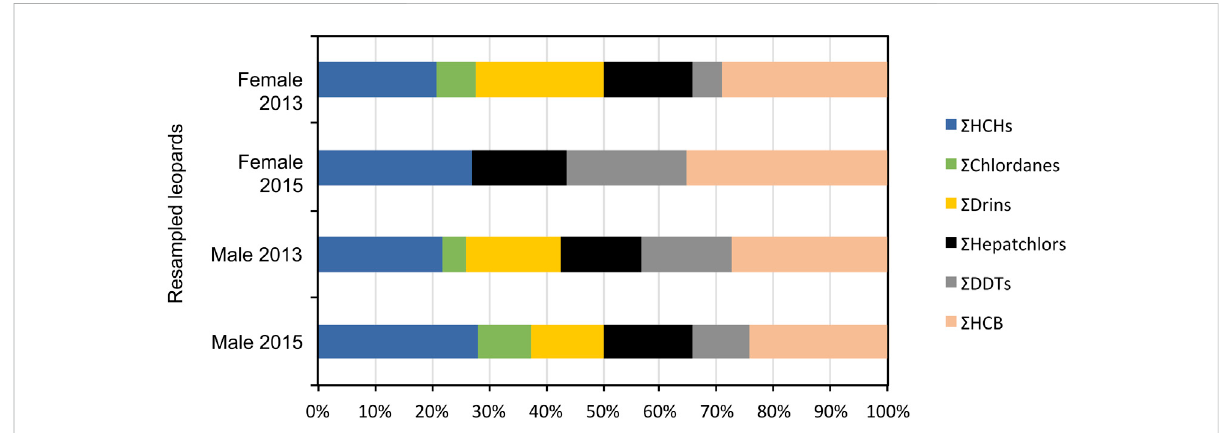
FIGURE 3 The relative contribution of main compound groups ( Σ HCHs; Σ Chlordanes; Σ Drins; Σ Heptachlors; Σ DDTs; Σ HCB) to Σ OCP concentrations as analyzed in the two resampled captive